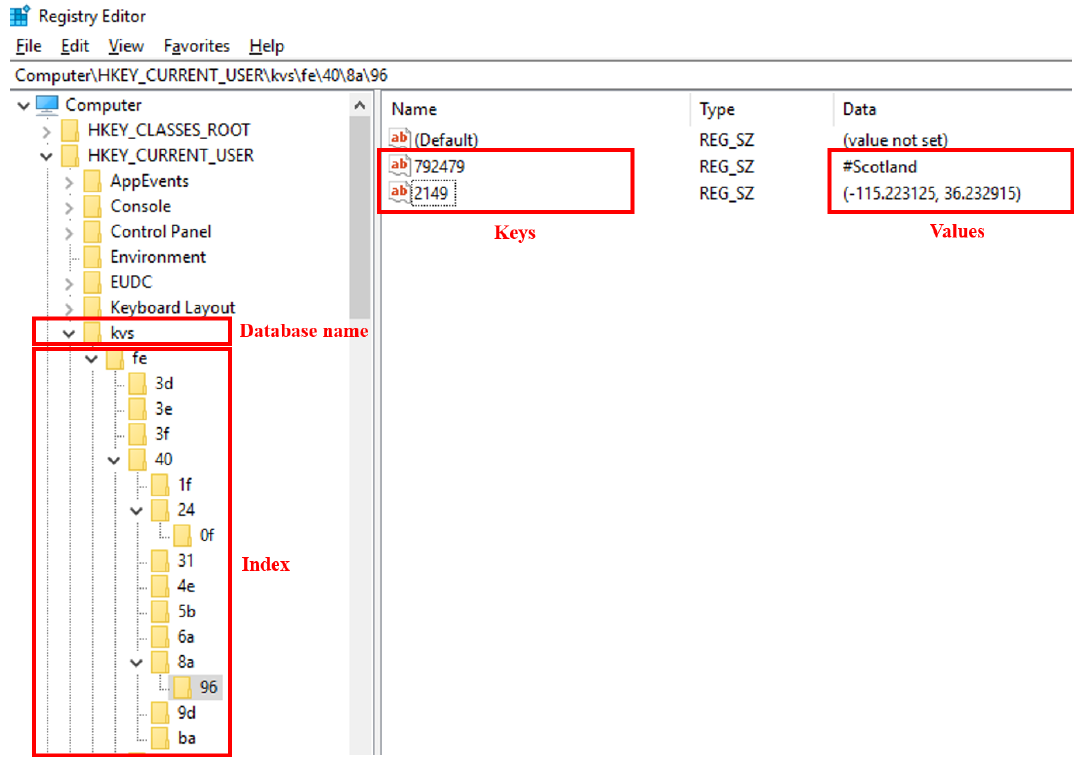
Figure 2. The concept of